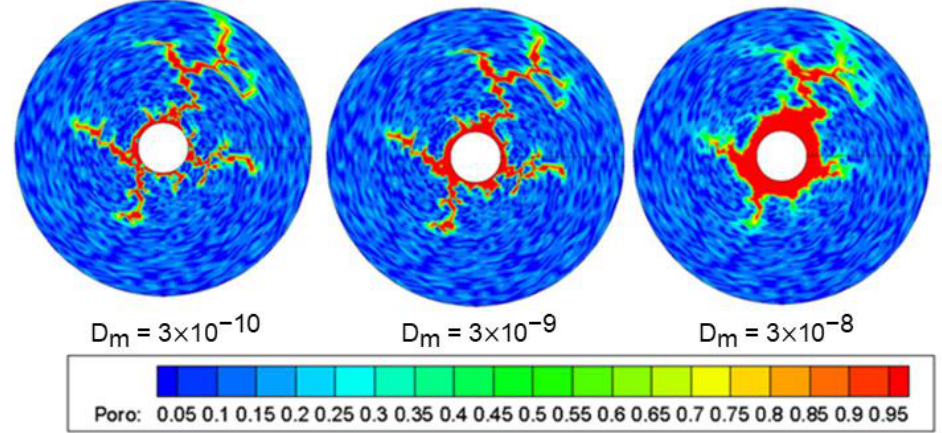
Figure 10. Effect of hydrogen ion diffusion coefficient on wormhole morphology.